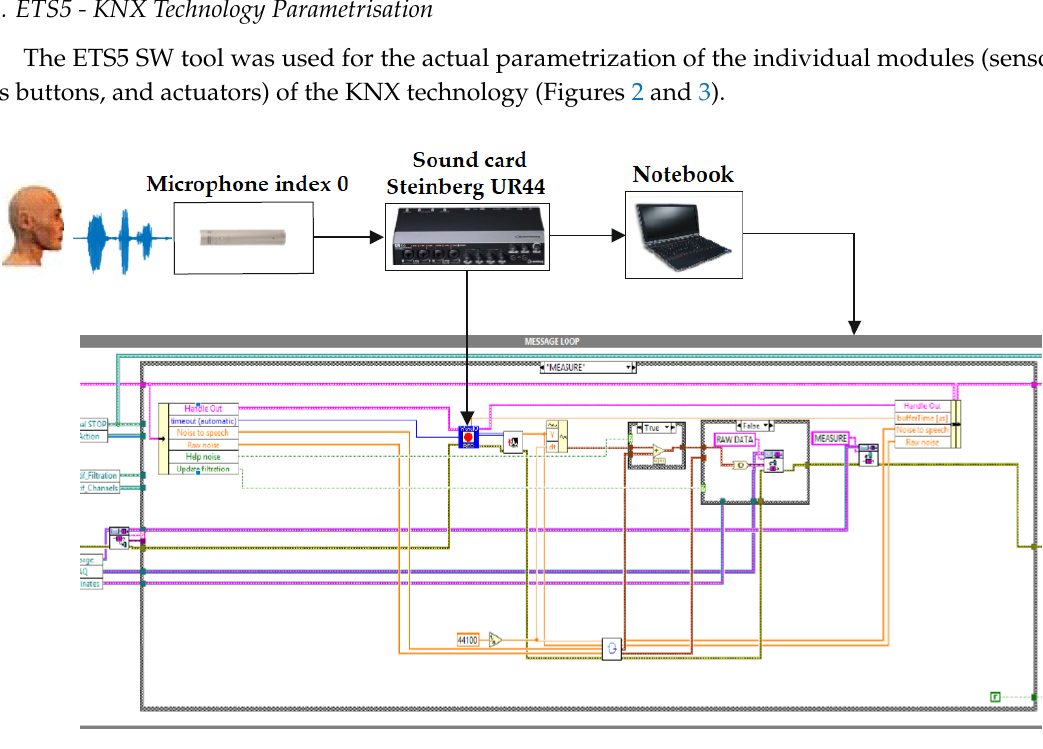
Figure 2. The main loop for continuous data